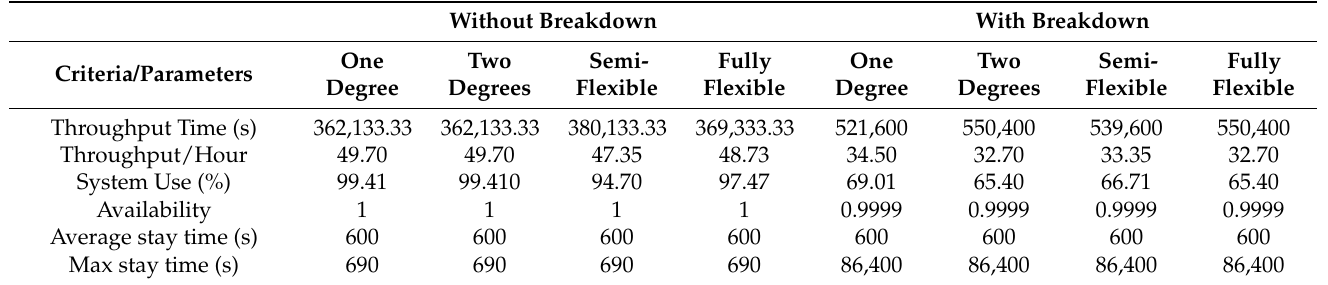
Table 2. Experimentation matrix of various parameters for 5000 jobs. Without